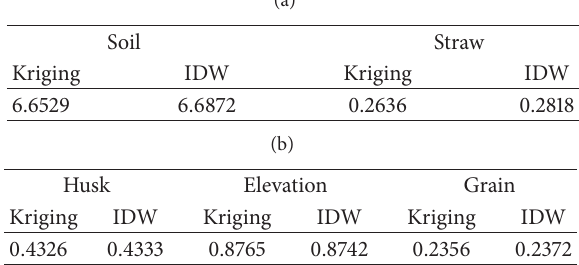
Table 5: Best interpolation method according to